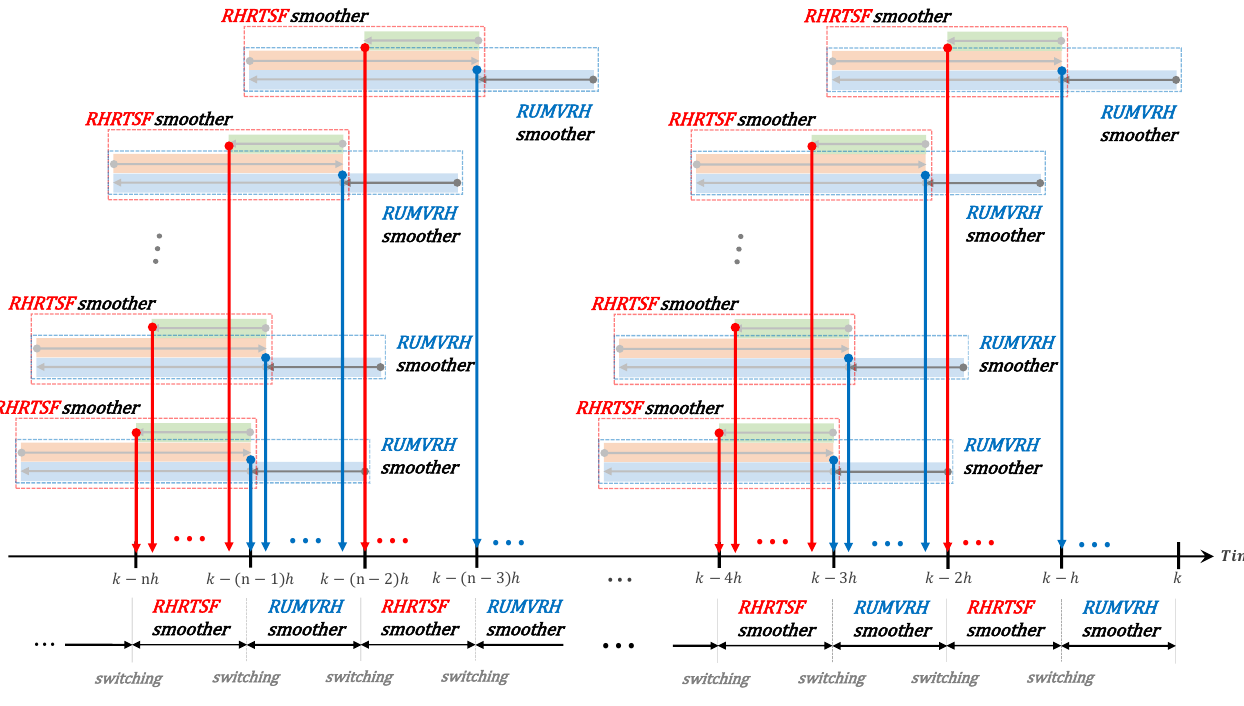
Figure 4. Concept of periodical swithcing scheme for RHCCRHF